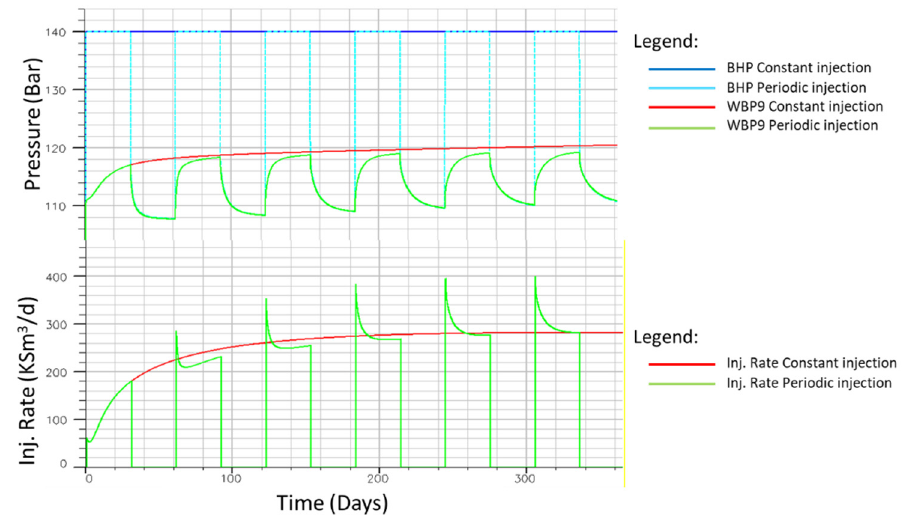
Figure 13. Bottom hole (BHP) and average near-well (WBP9) pressures and injection rates in the cases of continuous and periodic injection.